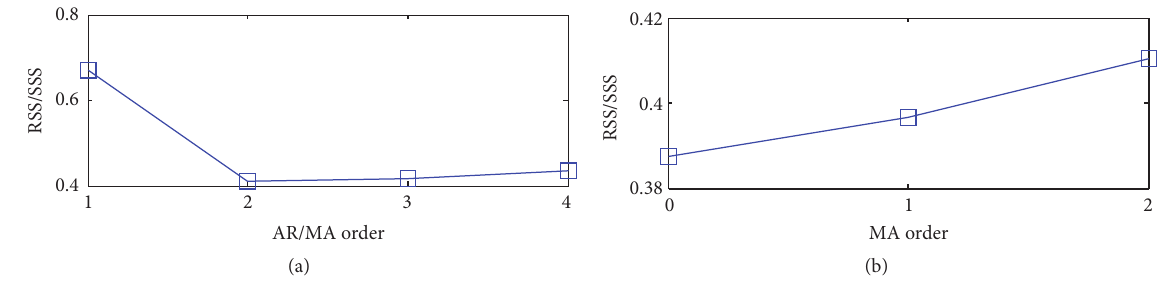
Figure 13: Exponentially weighted RPLR-TARMA model order selection: (a) AR order and (b) MA order.